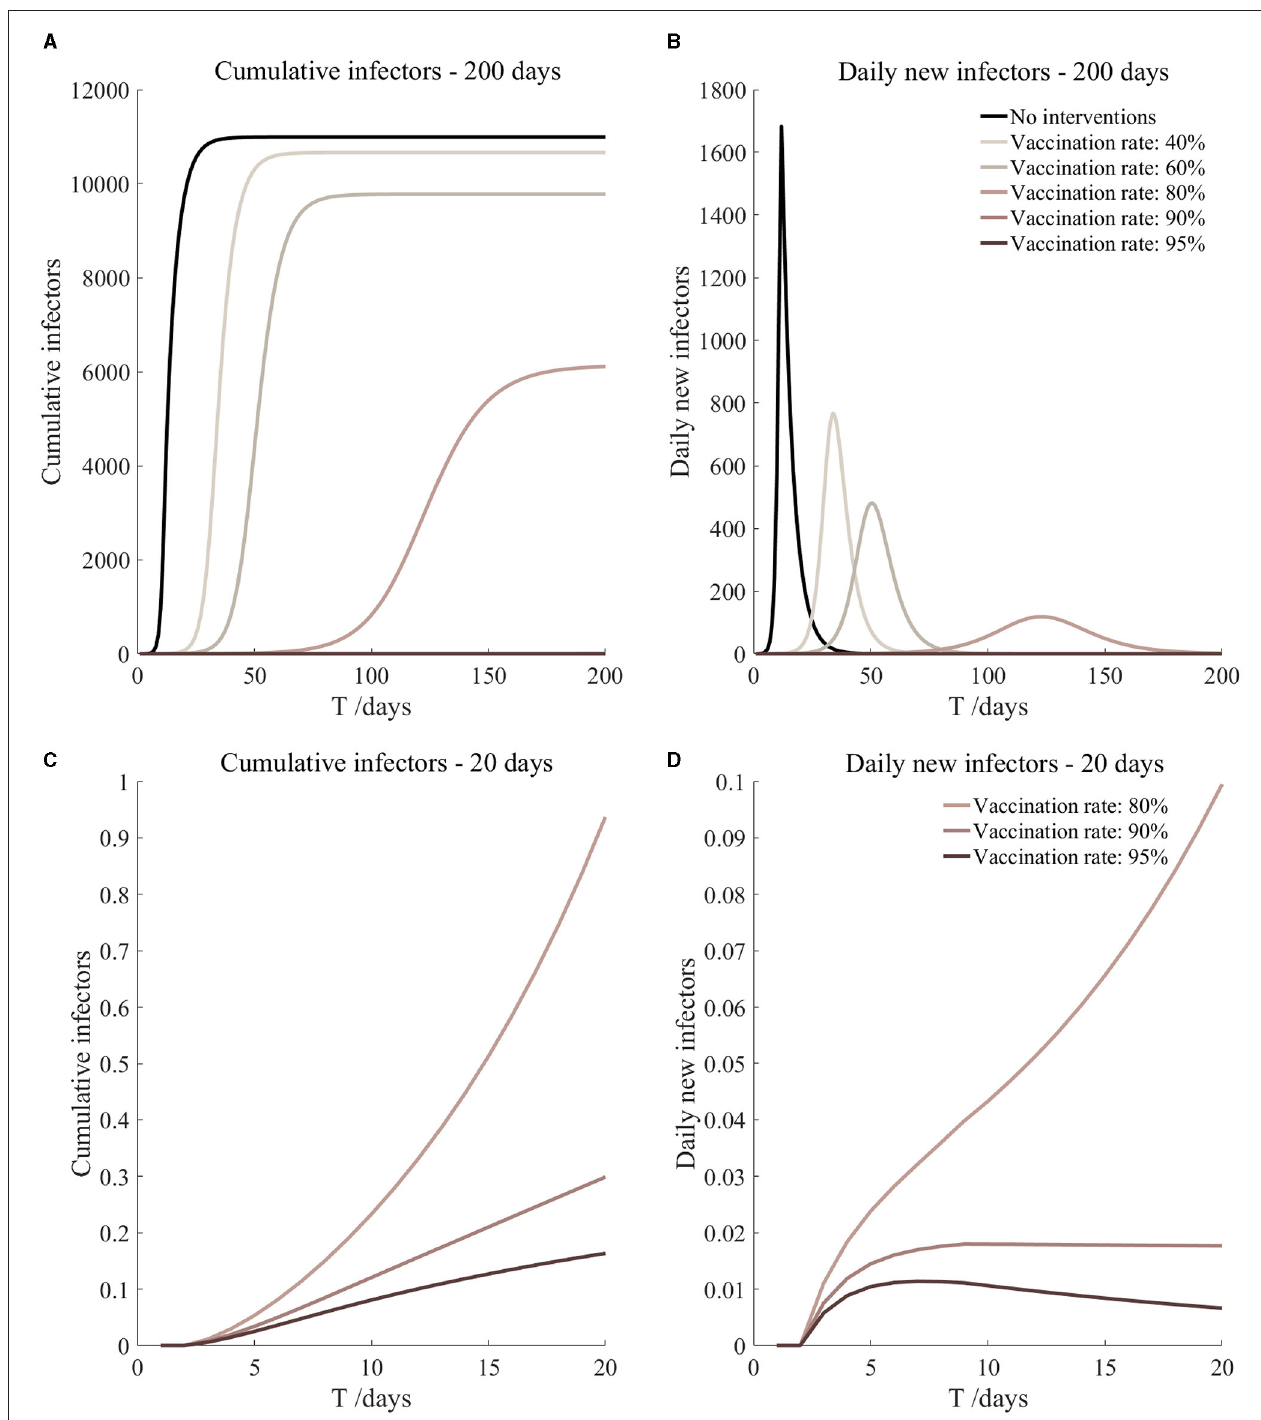
FIGURE 14 | Vaccination and 7-day compulsory quarantine. Assume pre-flight screening can identify 40% of asymptomatic infectors, 7-day compulsory quarantine has about an 18% risk of missed detection.